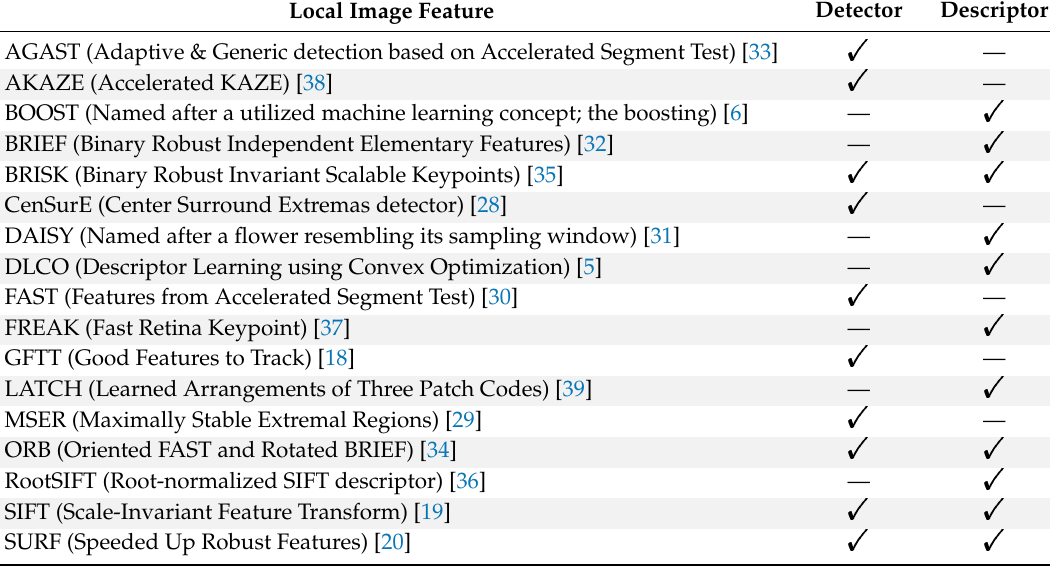
Table 2. List of 10 detectors and 11 descriptors against which the proposed embedding was evaluated. For practicality, all detectors were intermixed with a SIFT [19] descriptor, and all descriptors were intermixed with a SURF [20] detector. Local Image Feature Detector